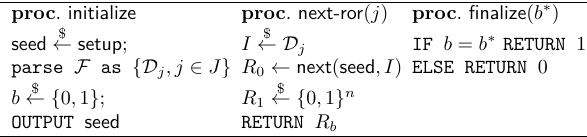
Figure 12: Procedures in Security Game RES ( F )